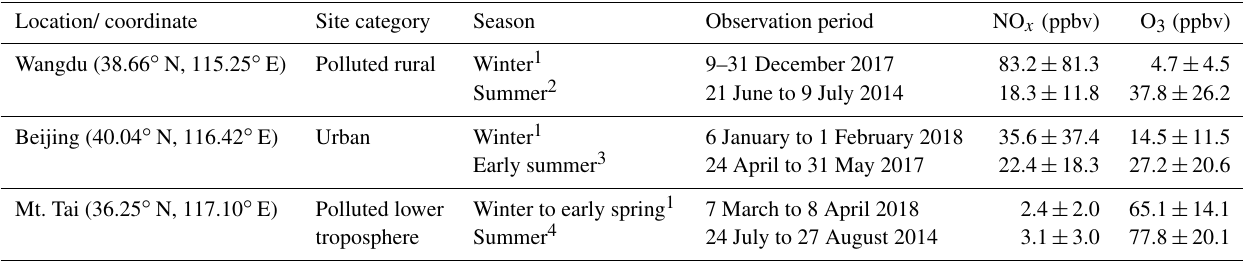
Table 1. Locations and periods of the field campaigns relevant to this study. Location/